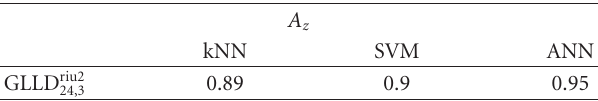
Table 5: A z comparison of the di ff erent methods of classification (SVM, kNN, ANN) when utilizing GLLD as a feature extraction technique.